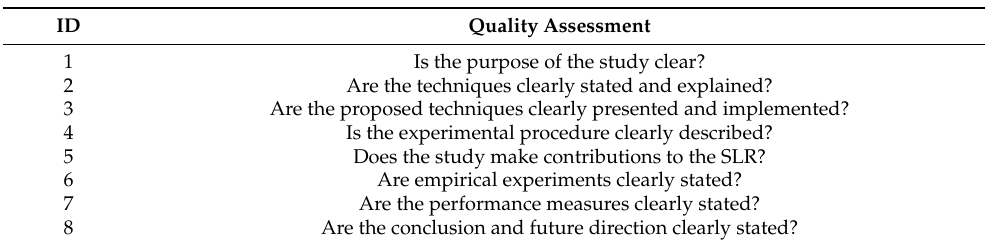
Table 3. Quality